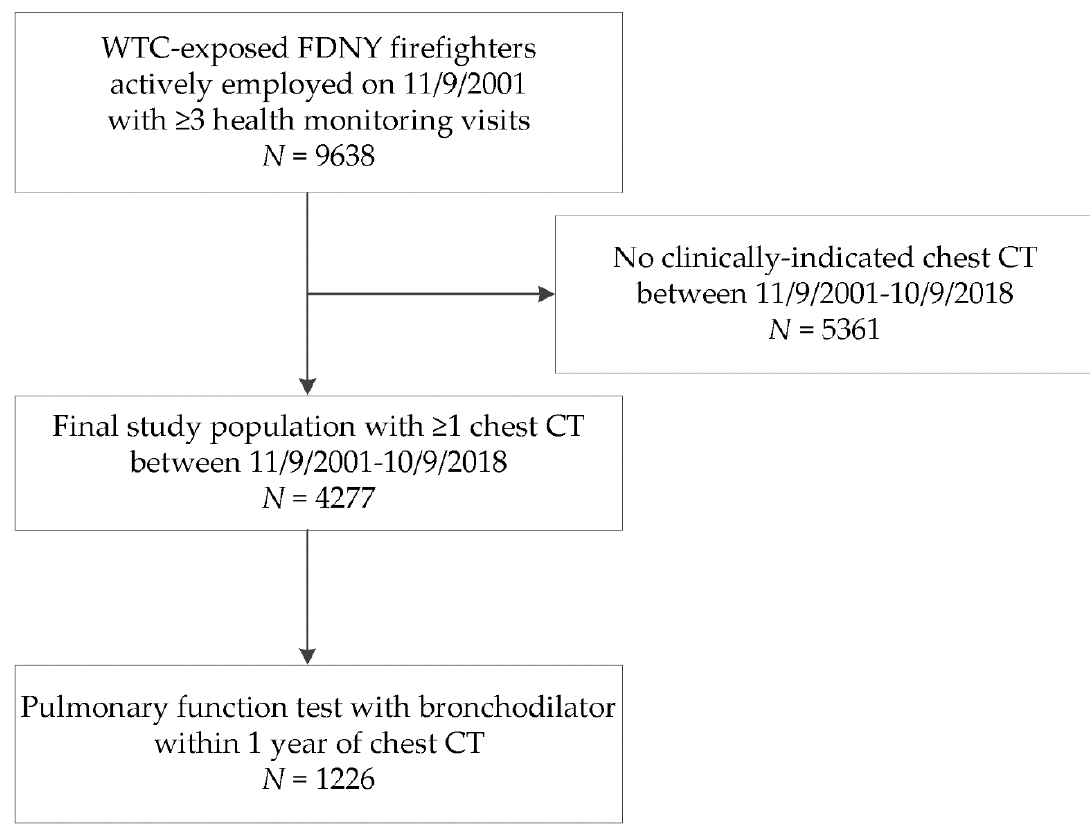
Figure 1. Firefighters who participated in the chest computed tomography (CT) study. Shown is the source population of male firefighters who were employed by the Fire Department of the City of New York (FDNY) on 11/9/2001, present at the World Trade Center (WTC) site between 11/9/2001 and 24/9/2001, and had at least three monitoring pulmonary function tests (PFTs) between 11/9/2001 – 10/9/2018 to assess longitudinal forced expiratory volume at one second (FEV 1 ) and FEV 1 /FVC (forced vital capacity). The final study population included those who had received a clinically-indicated chest CT scan between 11/9/2001 and 10/9/2018. A subgroup had a clinically-indicated bronchodilator PFT within one year of the chest